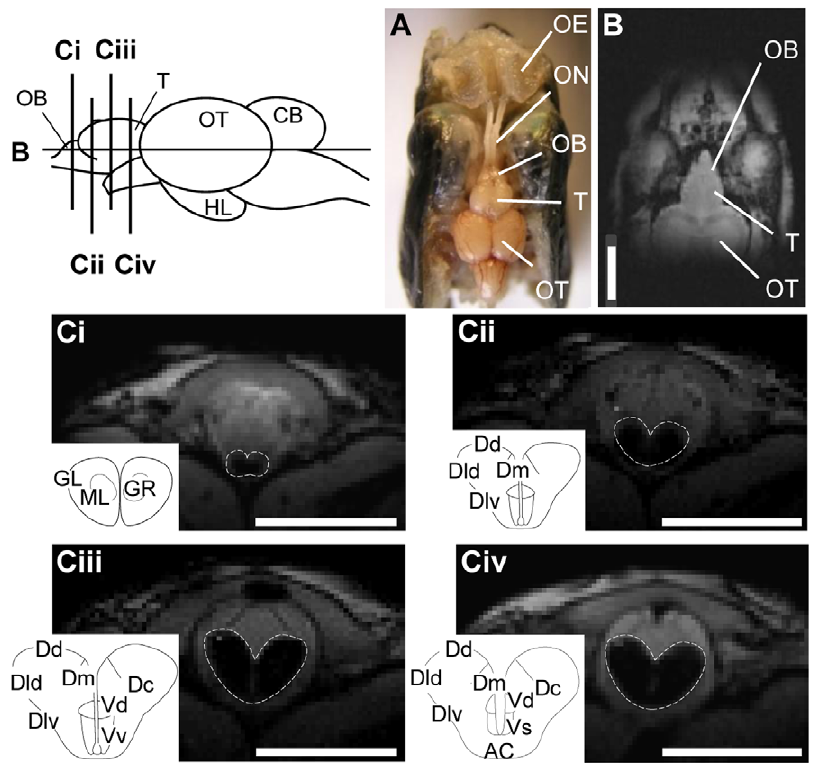
Figure 4. Magnetic resonance imaging (MRI) scan and dissected view of the front part of a lacustrine sockeye salmon head. A : Dissected view; B : MRI horizontal section; Ci–iv : serial MRI scan of frontal sections of the olfactory bulb ( Ci ) and the telencephalon ( Cii–iv ). The olfactory bulb and telencephalon are outlined by dotted lines. Scale bars=5.0 mm. AC, anterior commissure; CB, cerebellum; Dc, central area of dorsal telencephalon; Dd, dorsal area of dorsal telencephalon; Dld, dorsal part of lateral area of dorsal telencephalon; Dlv, ventral part of lateral area of dorsal telencephalon; Dm, medial area of dorsal telencephalon; GL, glomerular layer; GR, granular layer; HL, hypothalamus; ML, mitral cell layer; OB, olfactory bulb; OE, olfactory epithelium; ON, olfactory nerve; OT, optic tectum; T, telencephalon; Vd, dorsal area of ventral telencephalon; Vs supracommissural area of ventral telencephalon; Vv, ventral area of ventral telencephalon.